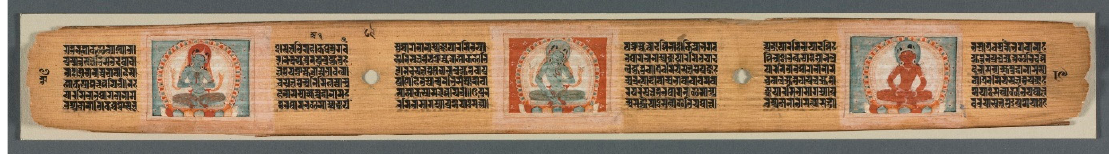
Figure 4. Three female figures, fol. 89v. Perfection of Wisdom in Eight Thousand Lines: A ṣṭ as ā hasrik ā Prajñ ā p ā ramit ā -s ū tra , 1119. India and Nepal. Gum tempera and ink on palm leaf. 5.9 × 55.9 cm. Cleveland Museum of Art, purchase from the J. H. Wade Fund, 1938.301.2.